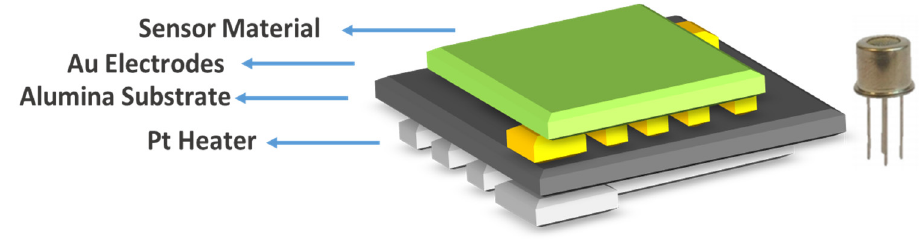
Figure 1. Sensor schematic of a spin-coated NiO device and the sensor package.